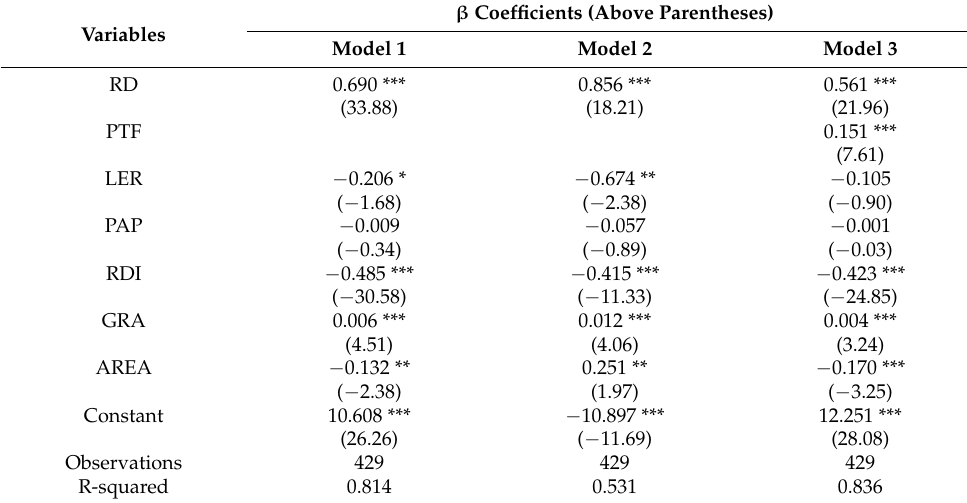
Table 3. Regression results of RD, PTF and OPE.